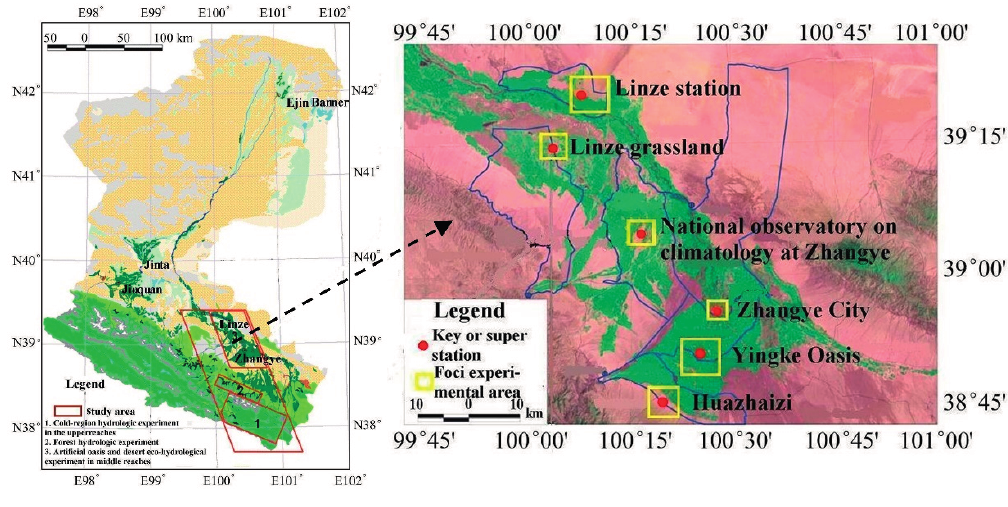
Figure 1. Heihe River Basin ( left ) and the locations of the Yingke oasis in the arid zone hydrology experiment area ( right ) (Referred to Li Xin et al.